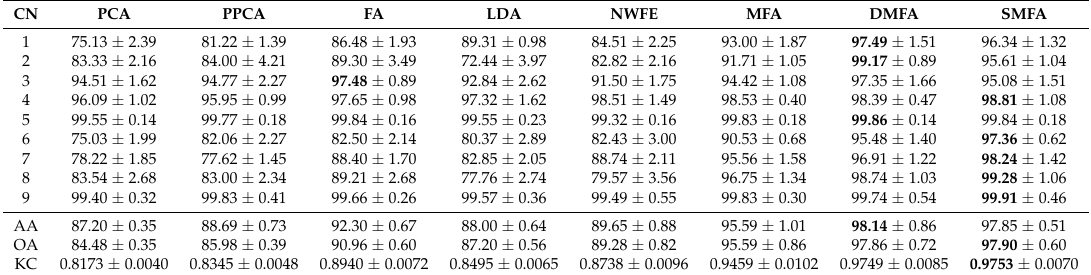
Table 5. The classification results (%) of different DR methods on the Indian Pines dataset, the best results are in bold typeface. The row of each class number (CN) is the mean accuracy ± standard deviation based on ten runs. The best classification results are given in bold typeface.